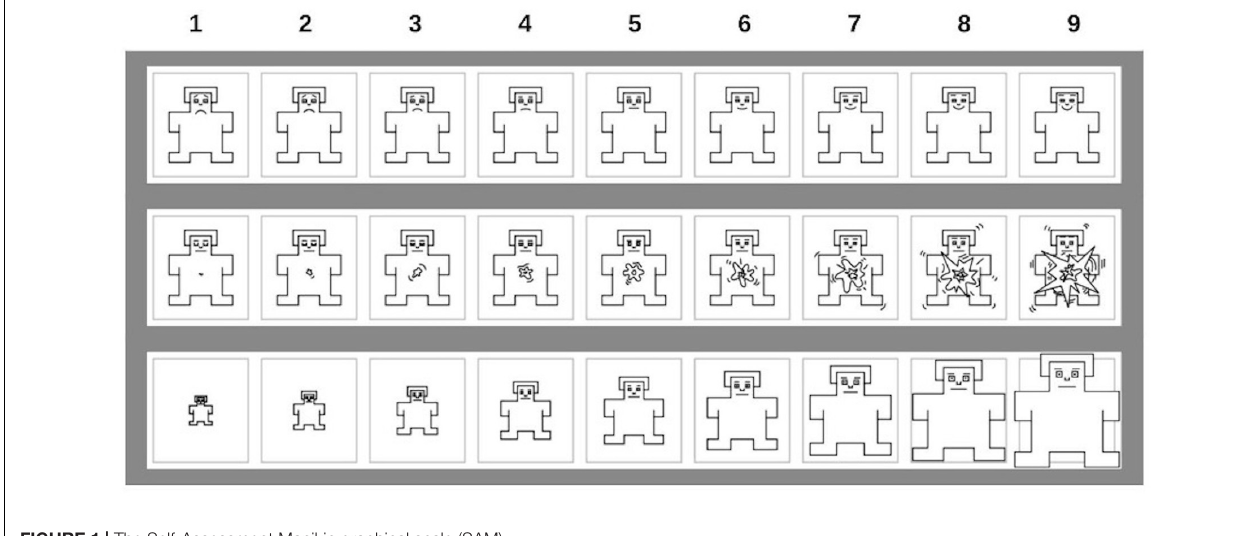
FIGURE 1 | The Self-Assessment Manikin graphical scale (SAM).